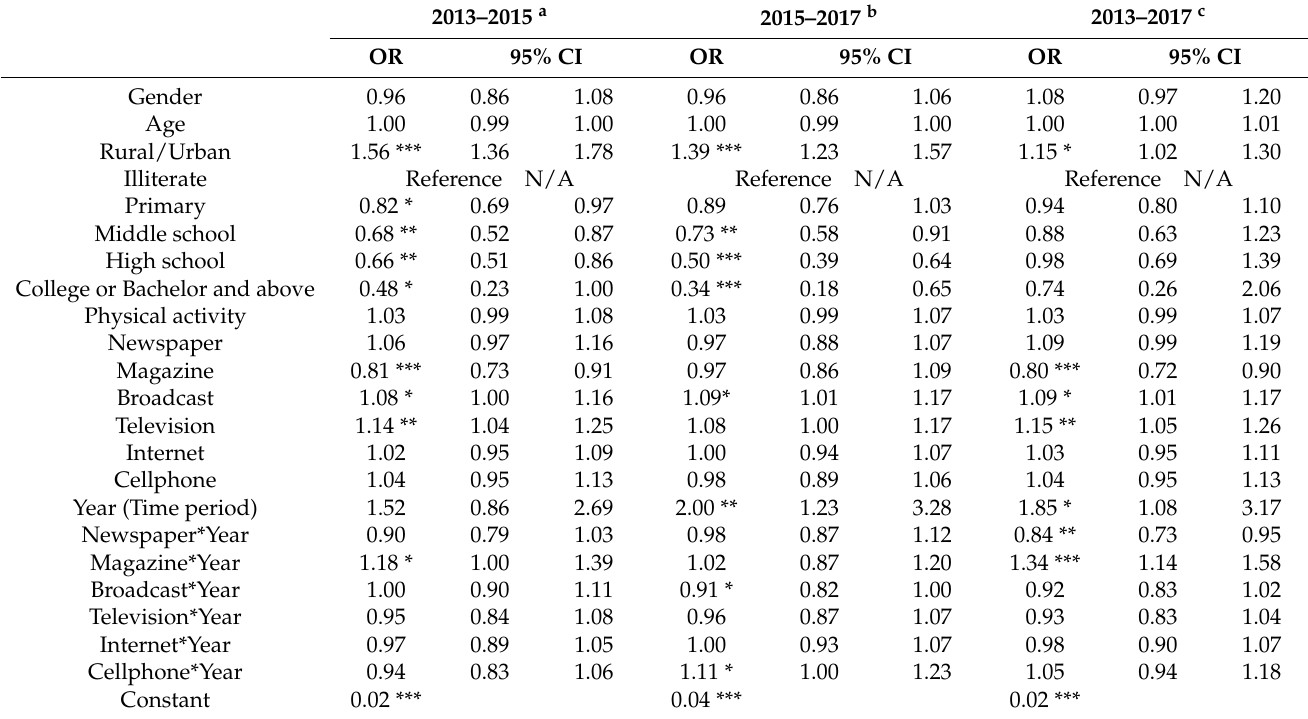
Table 3. Logistic regression analysis for the change in the associations between media use and obesity in 2013, 2015, and